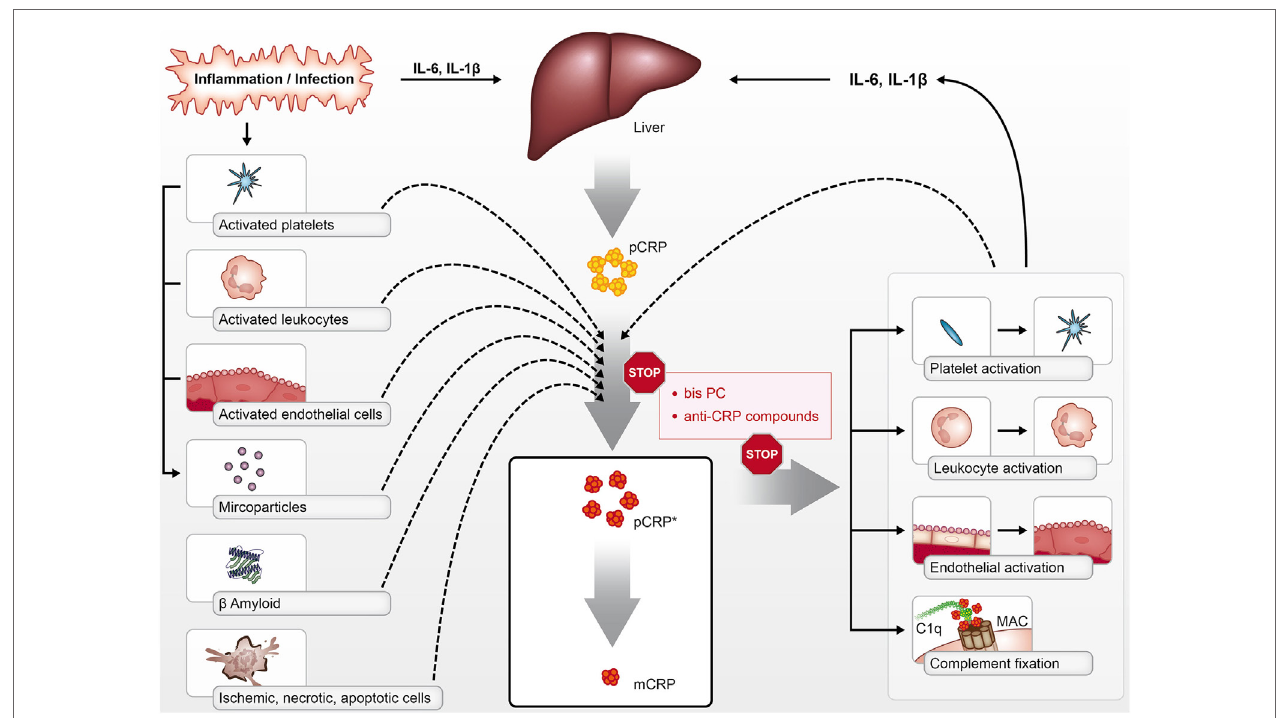
FiGURe 1 | pCRP is produced by the liver in the context of inflammation and infection in response to cytokines such as interleukin 6 (IL-6) and IL-1 β . pCRP can be dissociated into its pro-inflammatory structural isoforms [pCRP* and monomeric CRP (mCRP)] on the surface of activated platelets, leukocytes, endothelial cells, phosphocholine-rich MPs, dying cells, and beta-amyloid. pCRP* and mCRP can activate platelets, leukocytes, and endothelial cells, in addition to activating complement via C1q binding. The pro-inflammatory effects of pCRP*/mCRP can be inhibited with compounds such as bisPC that inhibit the dissociation of pCRP and block mCRP effector